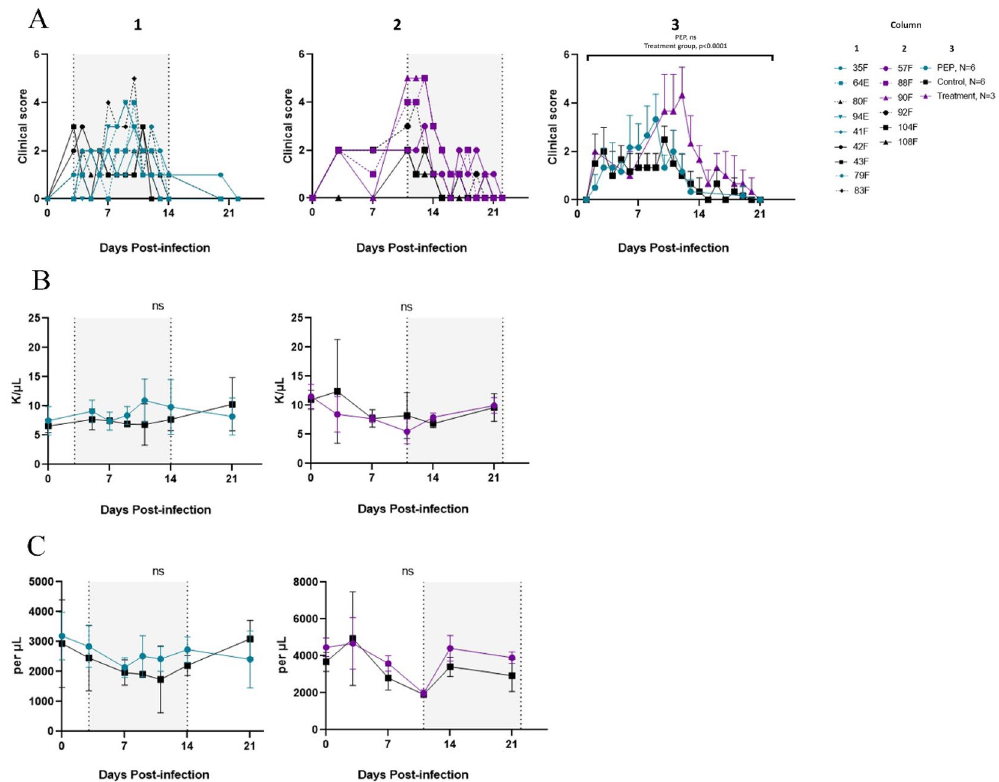
Figure 1. Clinical scores and laboratory results for MeV-infected macaques treated with remdesivir during the acute phase of disease. ( A ) Clinical scores obtained using a 10-parameter scale by two study veterinarians, blinded to treatment group. Column 1: Individual data from PEP study group and untreated controls; Column 2: Individual data from late treatment study group and untreated controls; Column 3: Averaged data with pooled untreated control group. ( B ) White blood cell count and ( C ) Absolute lymphocyte count (ALC) from DPI 0 to DPI 21. Note: number of untreated control monkeys for group-specific data is N = 3 each. Shaded areas indicate treatment